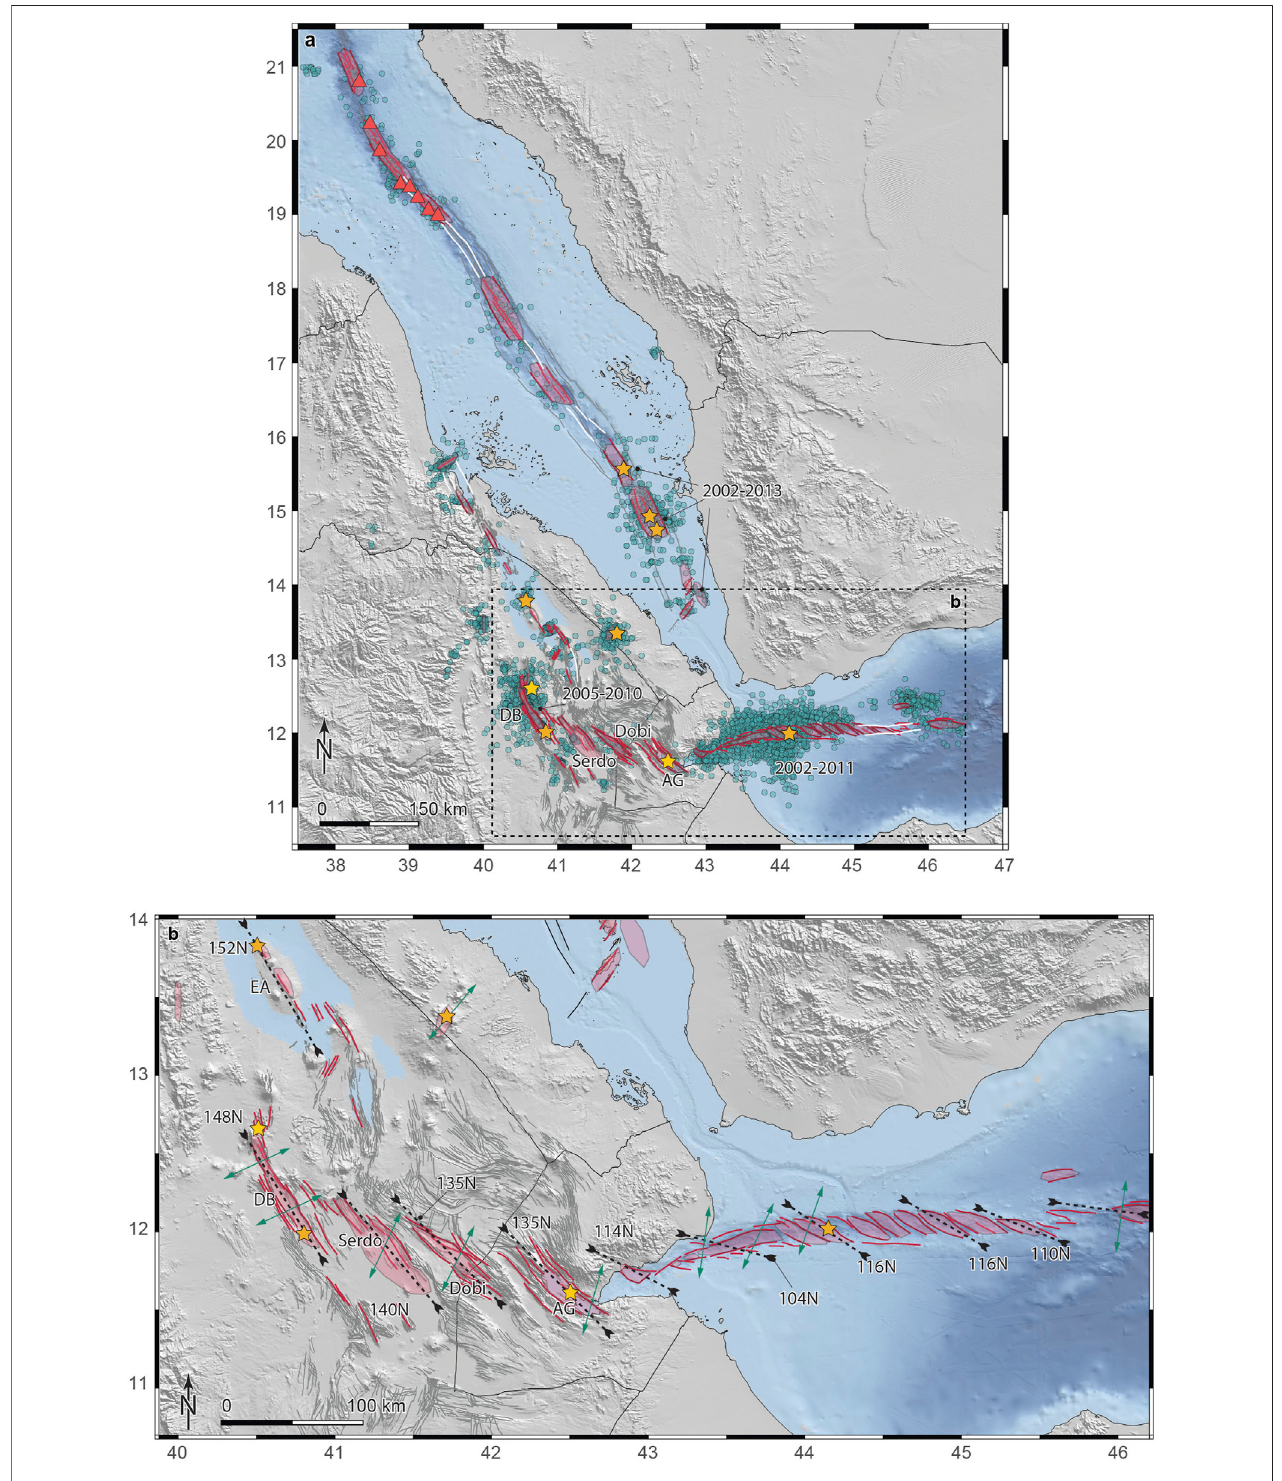
FIGURE 8| Earthquakeswarmsandtectonicactivityforthelast60 yearsintheSAGAregion. (A) Swarmlocationfrom1960to2017(greendots).Redlinesandsemi- transparent pink polygons show structures and portion of the active rift zones where swarms have been observed from 1960 to 2017. White lines show areas where no swarmshavebeendetectedfrom1960,alongknownplateboundaries.Yellowstarsarevolcaniceruptionlocations.Redtrianglesshowvolcanicventsandvolcanicdomesat seabottom(afterAugustinetal.,2016). (B) CloseupviewonthestructuralcontinuumfromGulfofAden(afterAhmedetal.,2016),AsalGhoubbet(AG),Dobi,Serdoand the Dabbahu magmatic segment (DB) characterized by oblique spreading and en-echelon extensional basins. Dashed lines with opposite arrows show the corresponding basin ’ s mean orientation. Green double arrows show the mean extension direction, extracted from focal mechanisms analysis. Erta Ale (EA) has a similar orientation that Dabbahu magmatic segment. Grey lines are fi rst order lineaments of the area; thin black lines show the coast line and the borders of the countries.